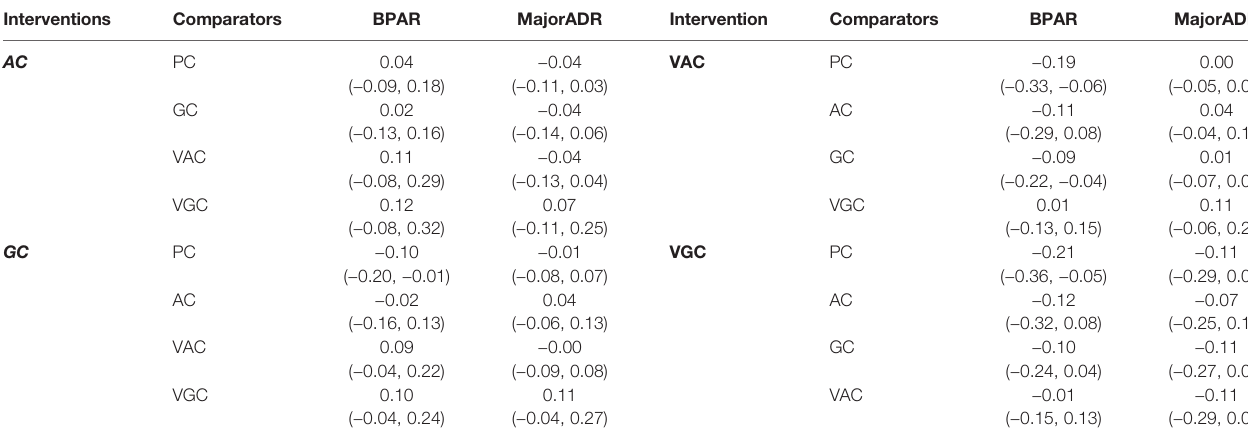
TABLE 3 | Results of the network meta-analysis of the incidence of BPAR and major ADR. Interventions